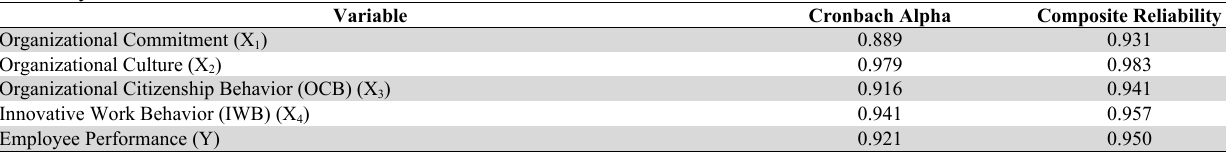
Reliability Test